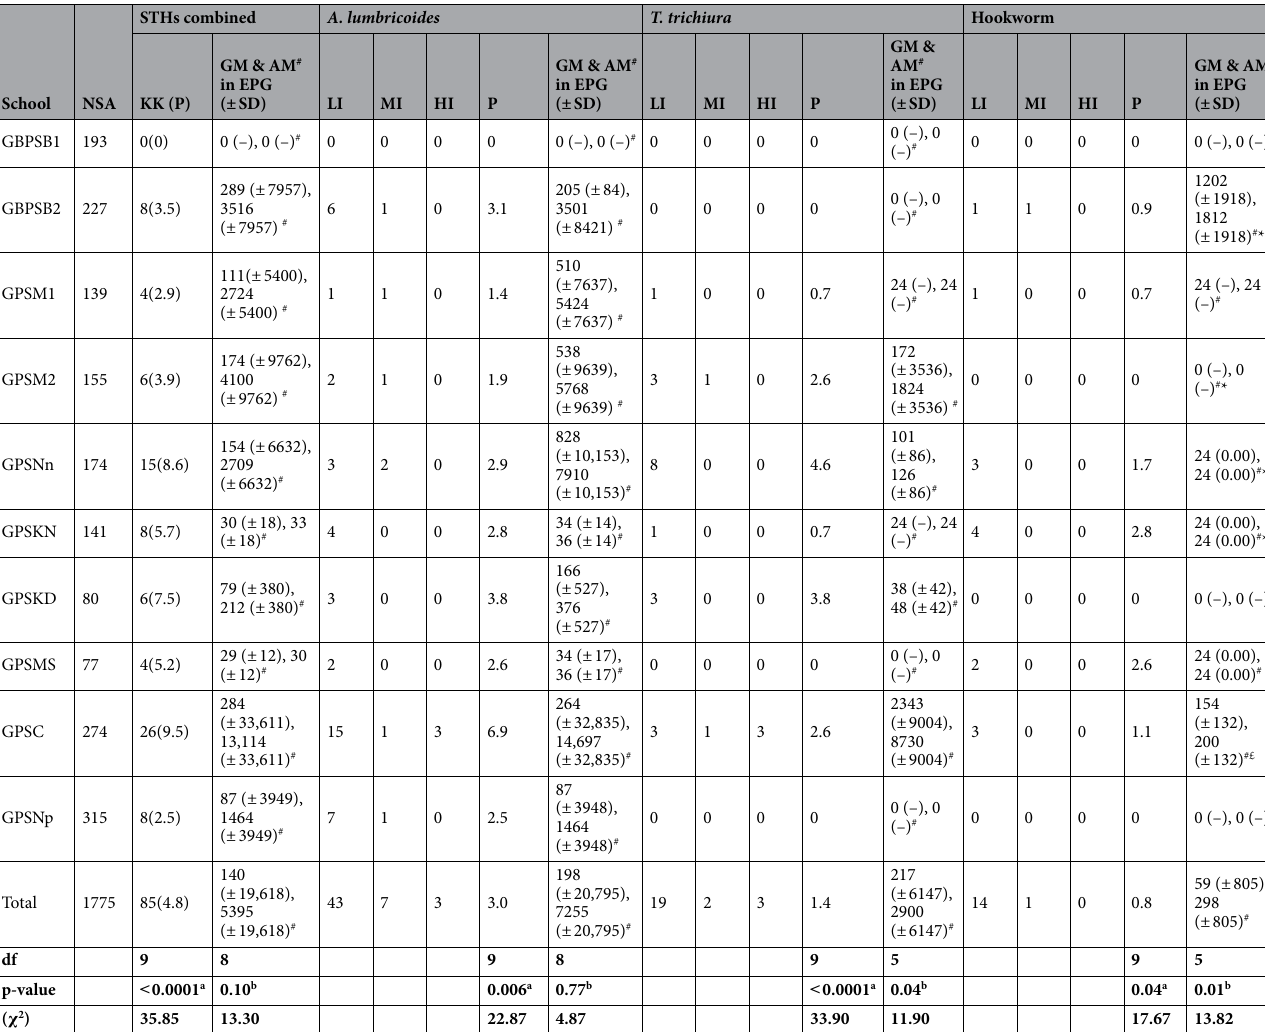
Table 3. Prevalence and infection intensities of soil-transmitted helminth species according to schools. STHs soil transmitted helminths; A. lumbricoides , Ascaris lumbricoides ; T. trichiura , Trichuris trichuria ; GBPSB1